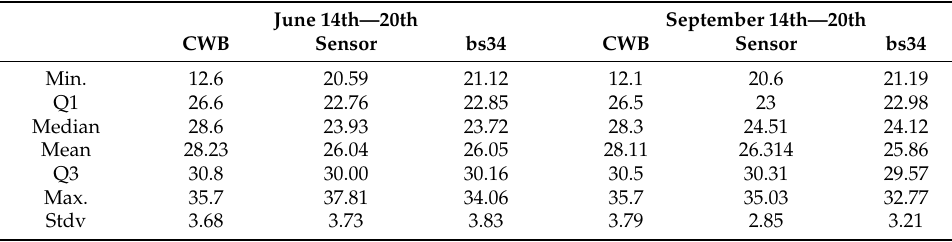
Table 3. Statistical descriptions of the raw data for